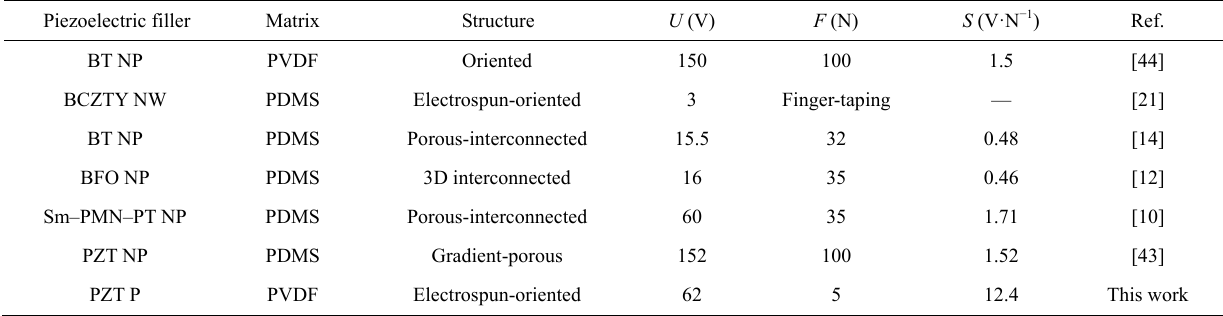
Table 1 Comparison of output performance with different porous structures Piezoelectric filler Matrix